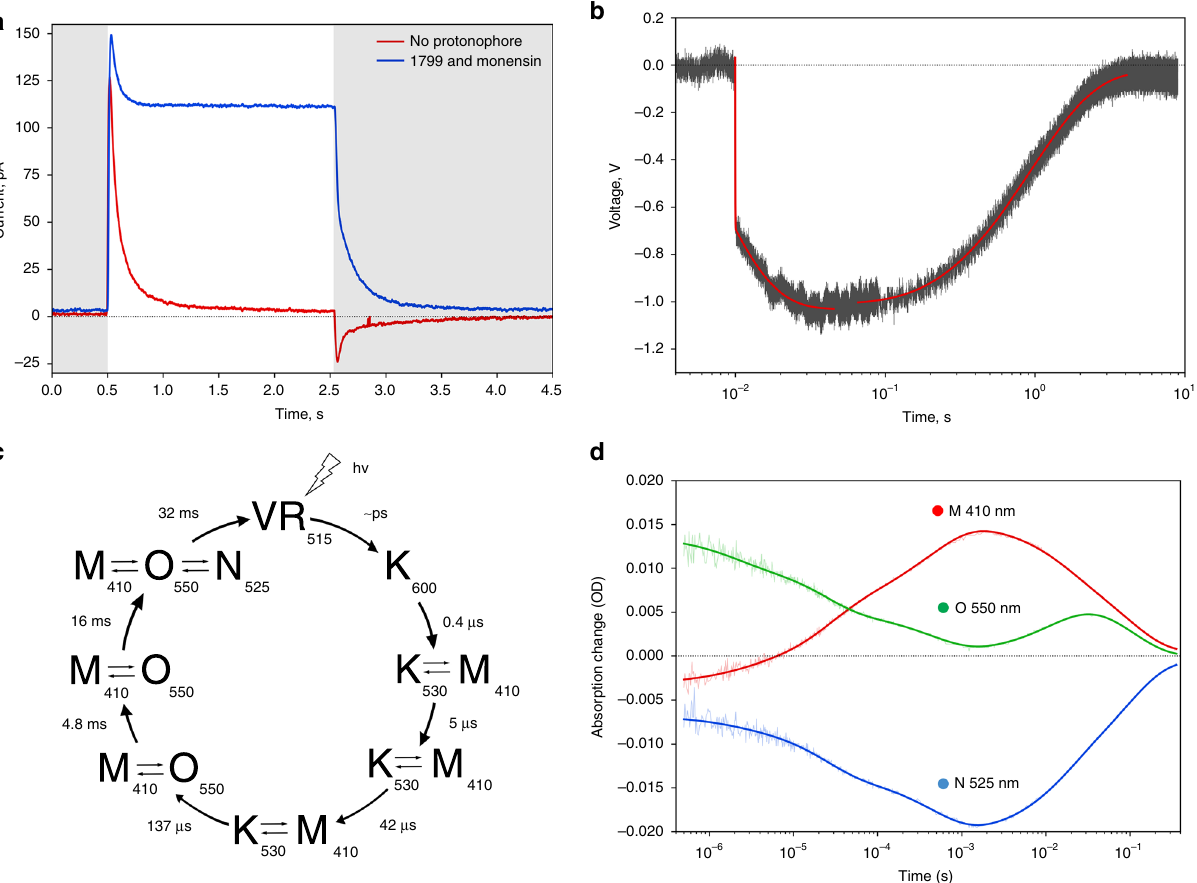
Fig. 5 Functional characterization of OLPVRII. a BLM measurements of OLPVRII in E. coli polar lipid liposomes. Red curve shows the electrical signal on BLM under illumination without addition of protonophore, while blue curve represents the signal under the same conditions, but after addition of 1799 and monensin. Illumination onset is indicated by gray (light off) and white (light on) colors. b Time-resolved BLM experiment. Electrical signal (gray) was recorded after laser fl ash and fi tted with the exponential decay curves (red). c Schematic representation of photocycle kinetics of the OLPVRII reconstituted into soybean liposomes. Lifetimes and absorption maxima of the intermediate states are indicated. d Time traces of the absorption changes of OLPVRII measured at 410, 525, and 550nm. Source data are provided as a Source Data fi